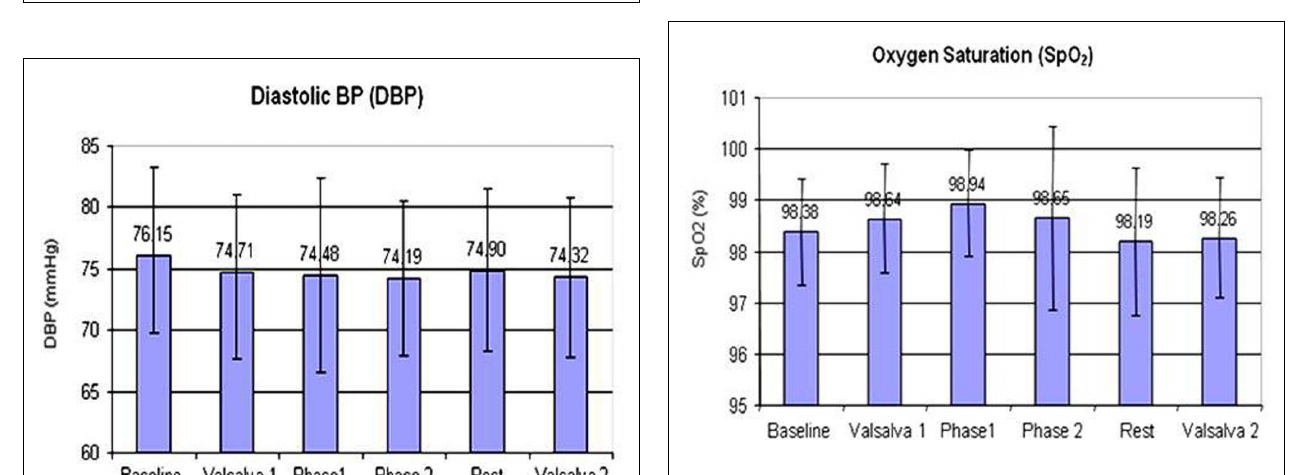
PERCENT OXYGEN SATURATION